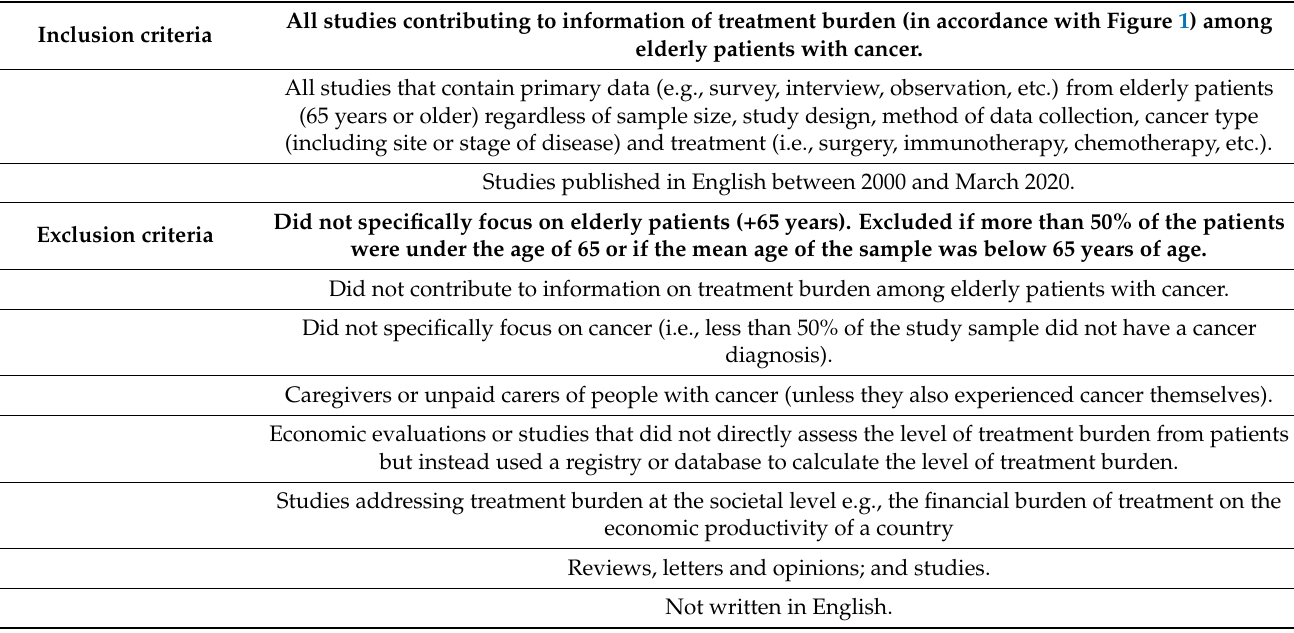
Table 1. Eligibility criteria for article selection inclusion